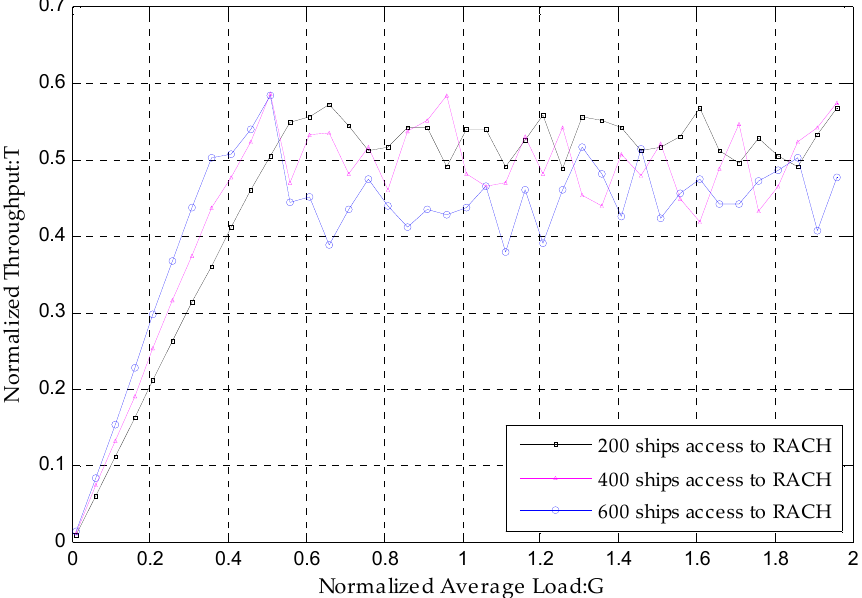
Figure 9. Normalized throughput under different loads.